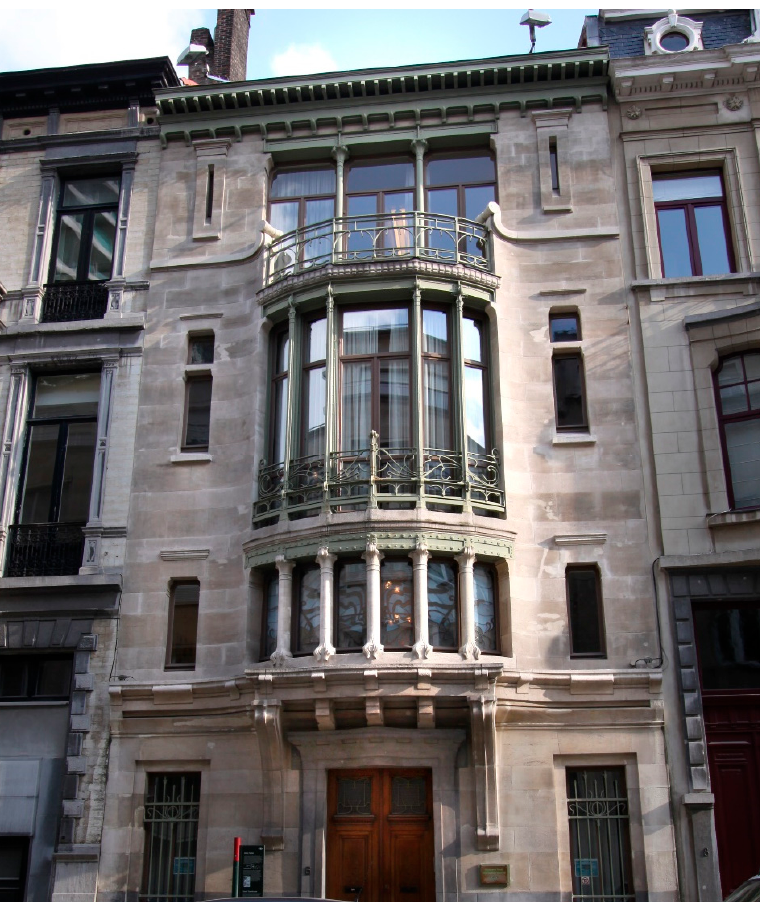
Figure 1. The façade of the Tassel House designed by Victor Horta.